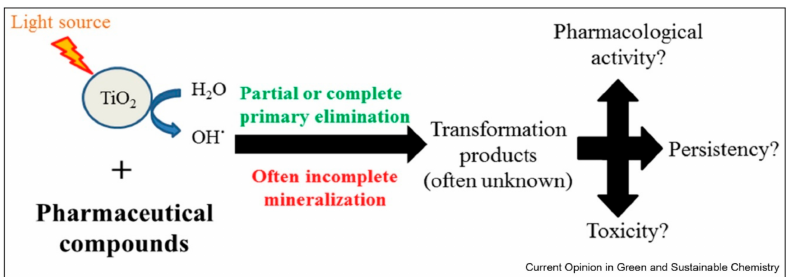
Figure 4. TiO 2 -related problems, copied with permission from Ref. [62], Copyright, 2021,